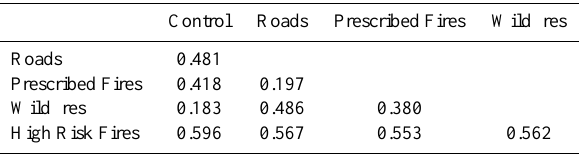
Table 3. Results of the Kolmogorov–Smirnov tests for difference in distance distributions. The value is the D statistic: the maximum difference in the y axis between lines displayed in Fig. 5. All com- parisons were significant at p < 0 . 001, except Wildfires vs. Control ( p = 0 . 002).